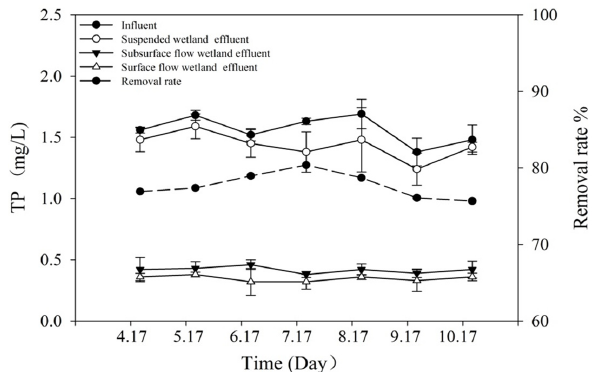
Figure 8. Concentration of TP in the inflow and outflow and the removal rate.